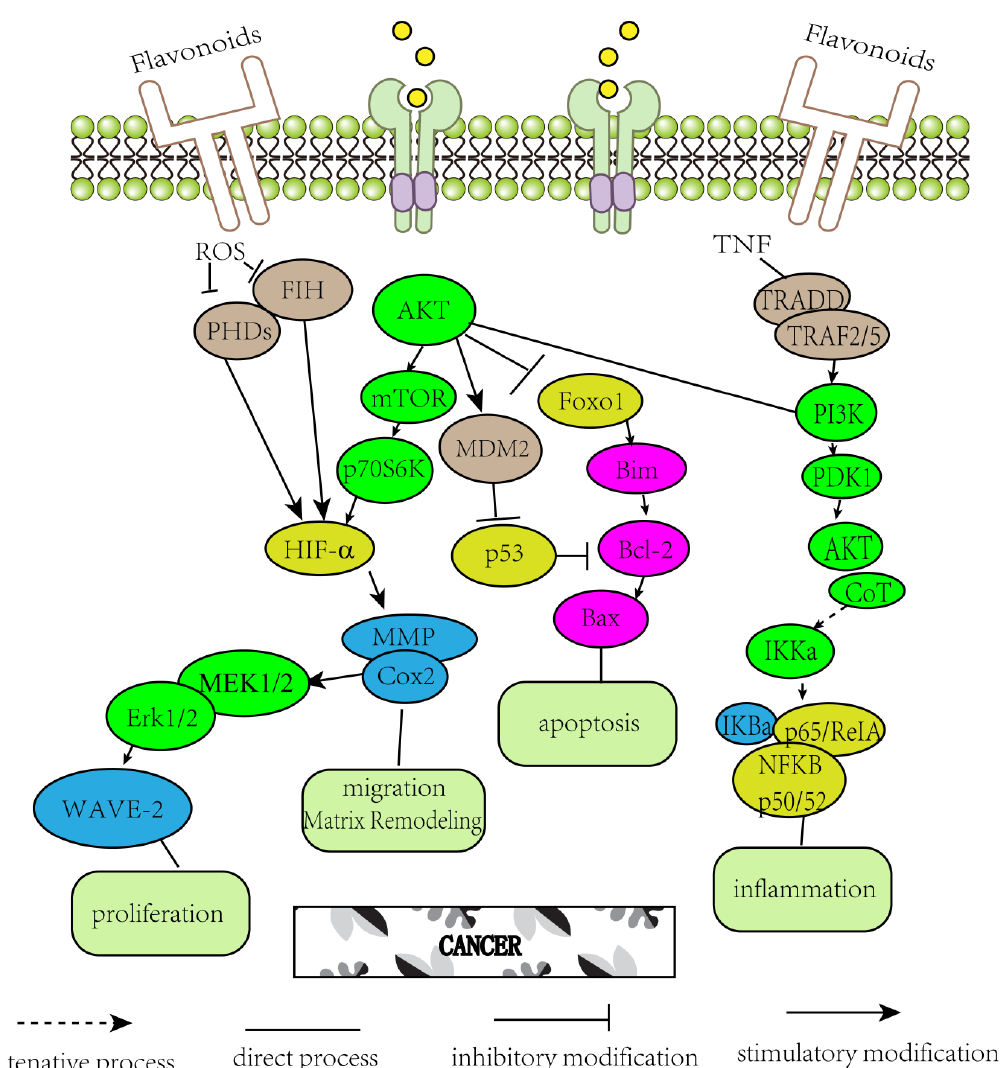
Figure 2. D emonstrated the role of major signaling pathways. Figure 2. Demonstrated the role of major signaling